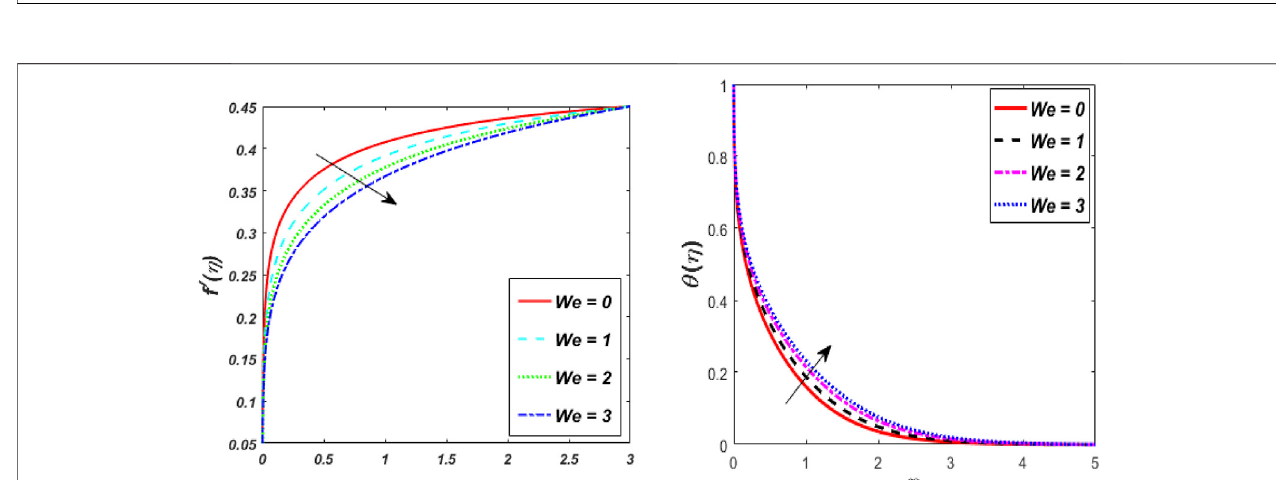
FIGURE 2 | M against f ′ ( η ) and θ ( η ) .